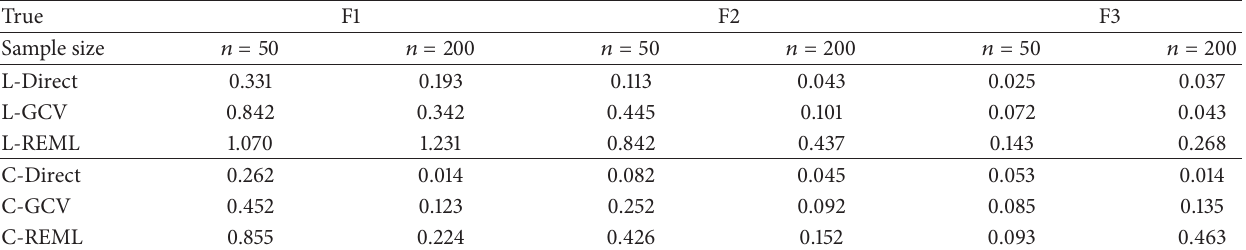
Table 2: Results of sample MSE of smoothing parameter obtained by direct method, GCV, and REML for 𝑛 = 50 and 𝑛 = 200 . All entries for MSE are 10 2 times their actual